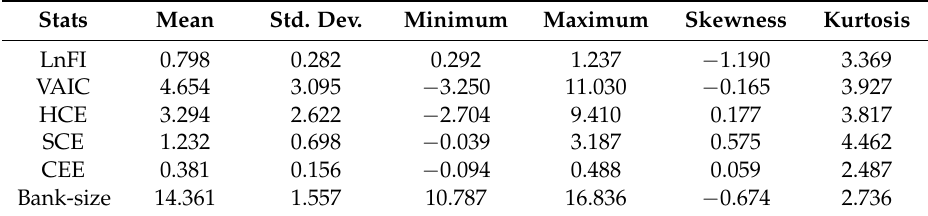
Table 1. Descriptive statistics.